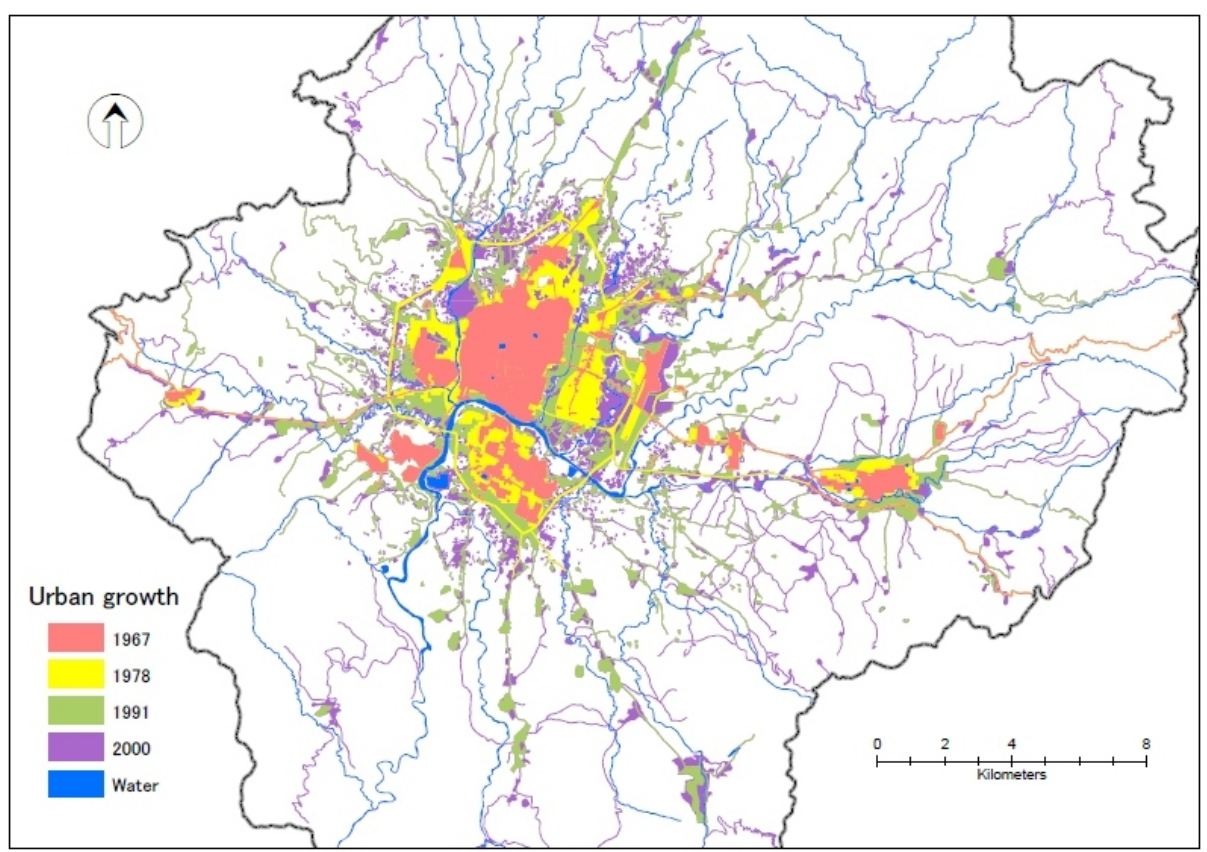
Figure 7. Spatial patterns of urbanization in Kathmandu